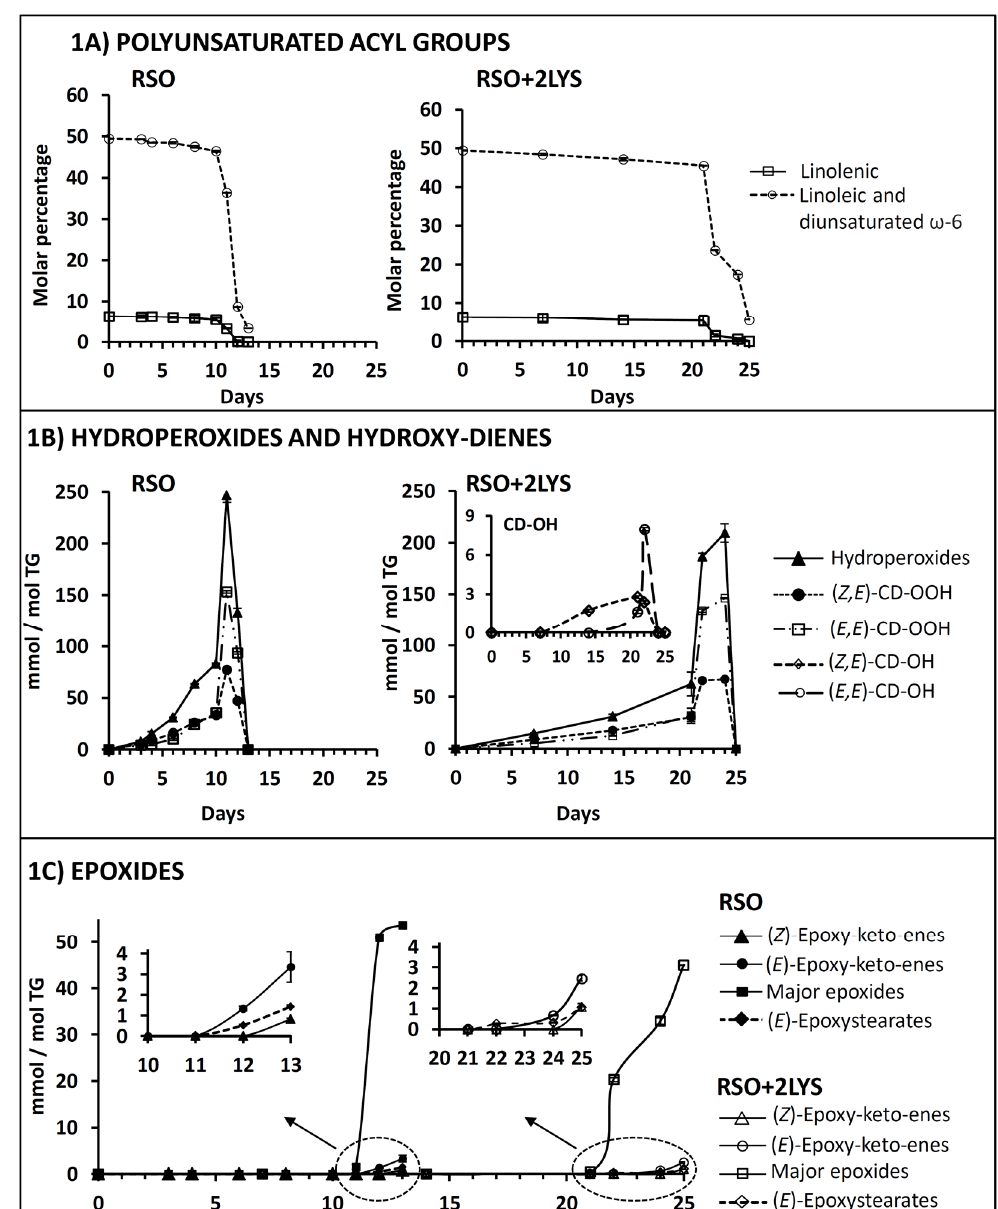
Figure 1. Evolution throughout the oxidation process, in the reference oil (RSO) and in the sample with lysine added (RSO + 2LYS), of: ( A ) the molar percentages of linolenic and linoleic acyl groups; ( B ) the concentrations, in mmol / mol TG, of hydroperoxides and their associated conjugated ( Z,E )- and ( E,E )-dienes (( Z,E )- and ( E,E )-CD-OOH), and of conjugated ( Z,E )- and ( E,E )-hydroxy-dienes (( Z,E )- and ( E,E )-CD-OH); and ( C ) the concentrations, in mmol / mol TG, of di ff erent kinds of epoxides. All the figures reported are mean values. RSO: refined soybean oil. 2LYS: 2% by weight of l -lysine. TG: triglyceride.